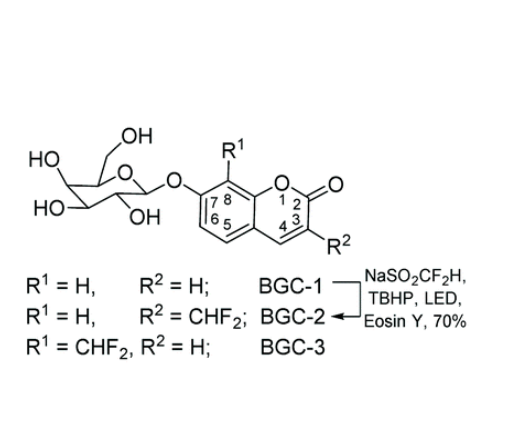
18 of 39 Figure 12. Activaton of SPiDER-killer- βGal. Adapted with permission from [56], copyright 2019 American Chemical Society. Inspired by Withers’ work [ 49], Jiang and colleagues described a coumarin activated by β -galactosidase that utilized p -QM masked with a difluoromethyl group [58]. It was shown in previous examples that the difluoromethyl group can lead to the diffusion of the quinone methide resulting in lower labeling efficiency and weak fluorescence, but the authors hypothesized that moving the difluoromethyl group to the 3-position of the cou- marin core would enhance the probe’s properties ( Figure 13a). This change in structure would probably generate a stronger fluorescent emission while diminishing steric hin- drance towards the enzyme. The difluoromethylation was carried out by a photochemi- cally-induced radical reaction from the corresponding coumarin (BGC-1) in one step, yielding the probe BGC-2. The new probe displayed a 60 nm batochromic shift in the ab- sorption wavelength compared to BCG-3, and had an over 200-fold fluorogenicity upon β -galactosidase activity. The emission spectrum of BCG-2 in PBS was similar to the 3- formylated coumarin derivative, revealing that a part of QM reacted with water instead of protein. SDS- PAGE experiments were also performed: the probe was incubated with β -